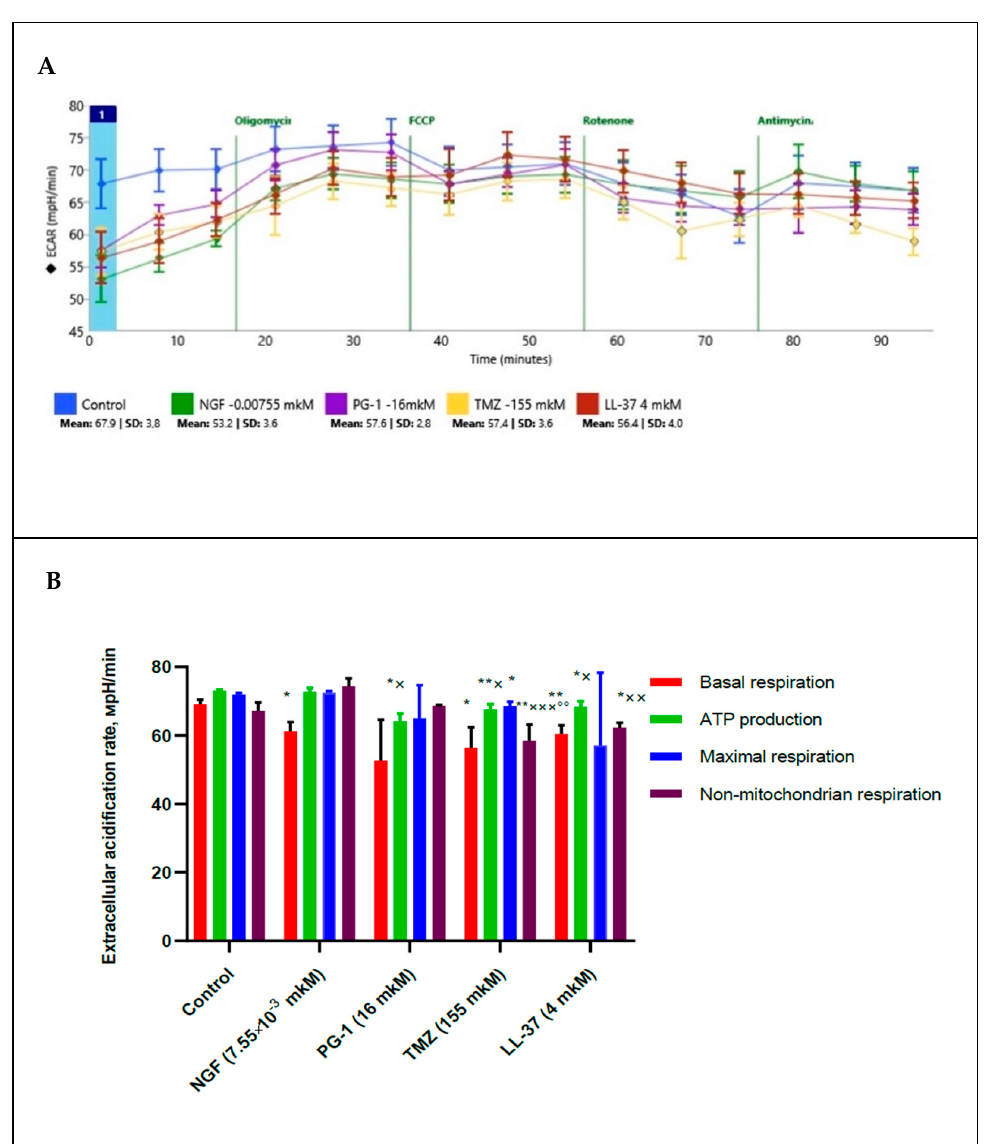
Figure 3. Extracellular acidification rate (ECAR) in human U251 glioma cells under the effect of NGF (7.55 × 10 − 3 μМ ), LL-37 (4 μМ ), PG-1 (16 μМ ), and TMZ (155 μМ ) over time ( A ); in comparison to control with reagents ( B ): *—significance ( p ≤ 0.05), ** ( p < 0.01) from control; ×—significance ( p ≤ 0.05), ×× ( p < 0.01), ××× ( p < 0.001) from NGF; °°—significance ( p < 0.01) from PG-1. The data presented in Figure 3 demonstrate that TMZ (155 μМ ) and LL-37 (4 μМ ) decrease ( p = 0.0043, and p = 0.0022) of extracellular acidification rate for a non-mitochondrial respiration in regard to control. PG-1, TMZ and LL-37 inhibited ECAR for ATP production in regard to control. TMZ also reduced ECAR for maximal respiration from